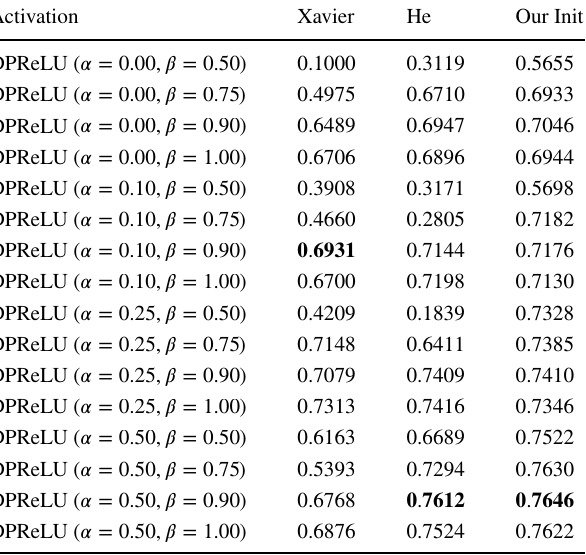
Table 6 Ablation study result for each learnable parameter